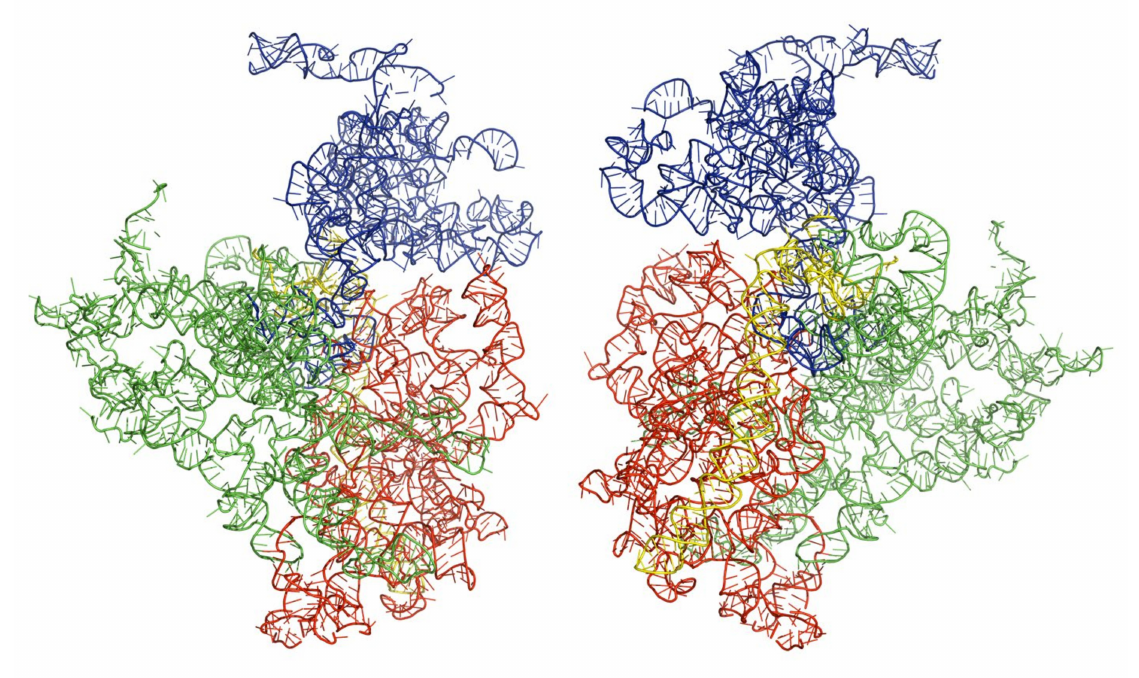
Figure 3. Architectural tertiary structure of Trypanosoma cruzi 18S rRNA front and back view. Shown is the 18S rRNA, colored differently depending on domains (5 (cid:48) major—red, Central—green, 3 (cid:48) major—blue, and 3 (cid:48)